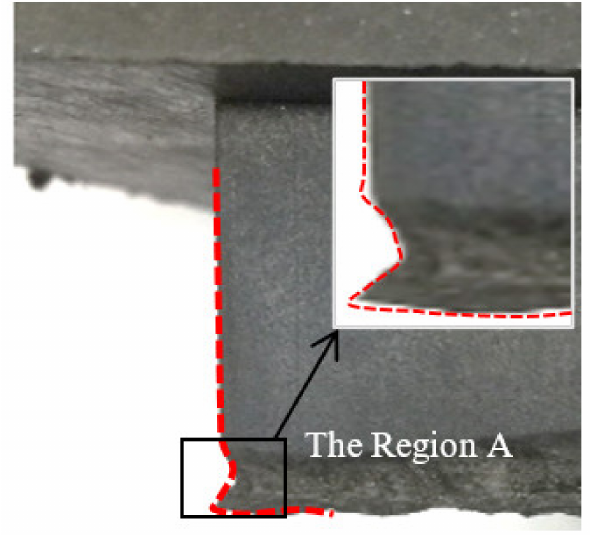
Figure 7. Wear loss of the region